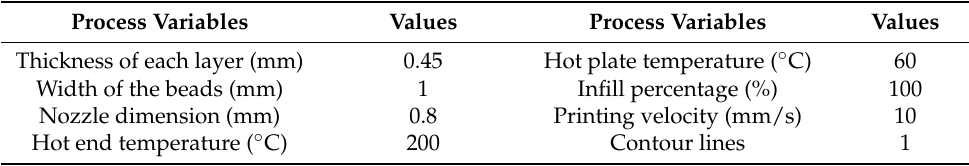
Table 1. The processing variables that were used for printing.